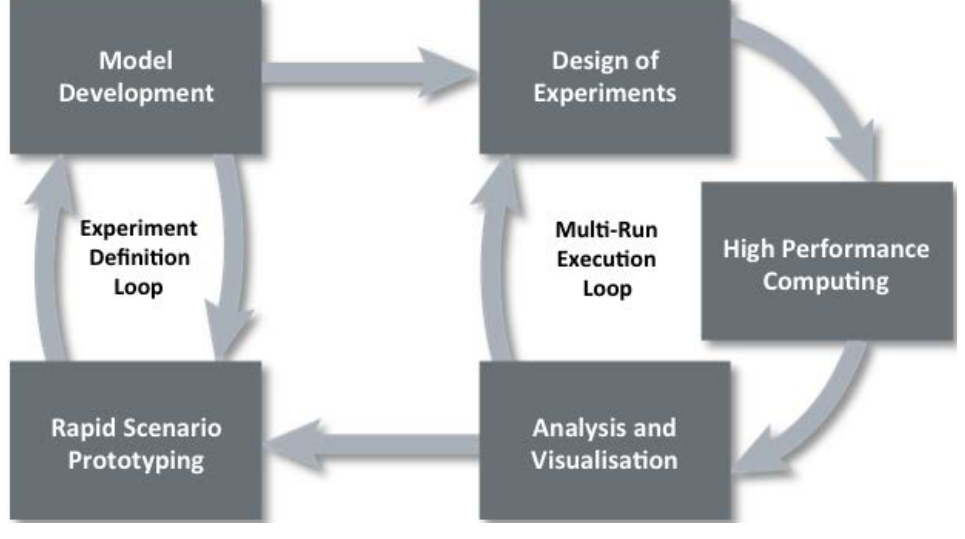
Figure 2. Data farming “loop of loops” [1].